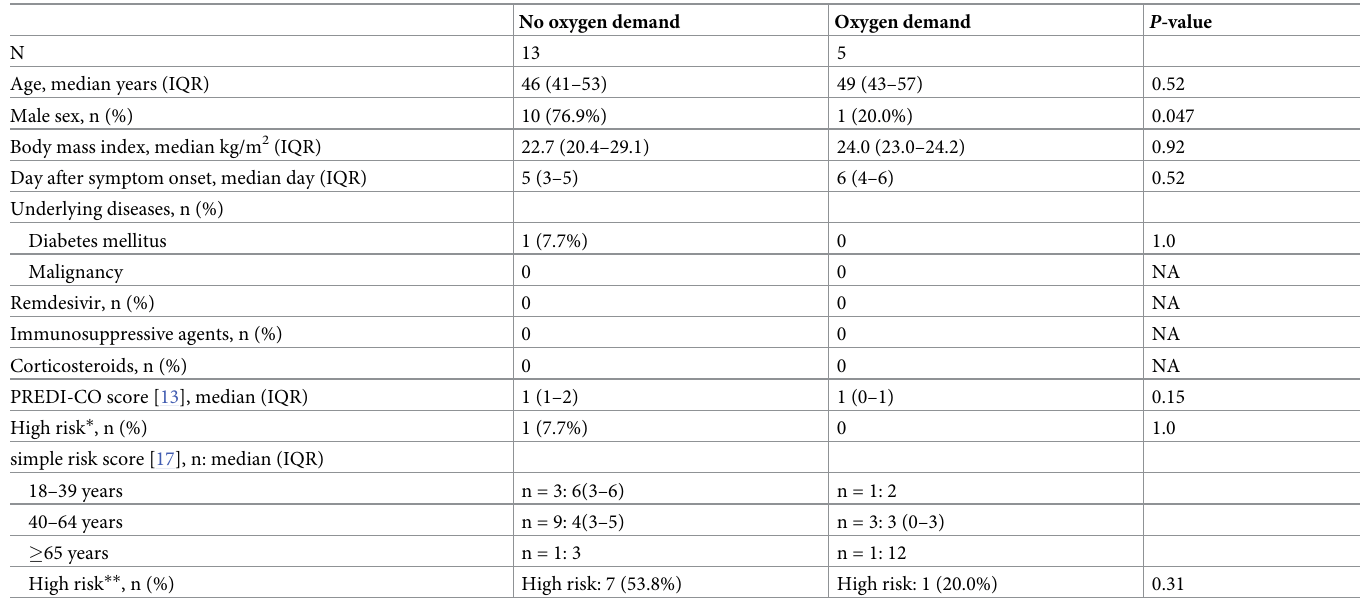
Table 1. Patient characteristics at serum sampling in Study